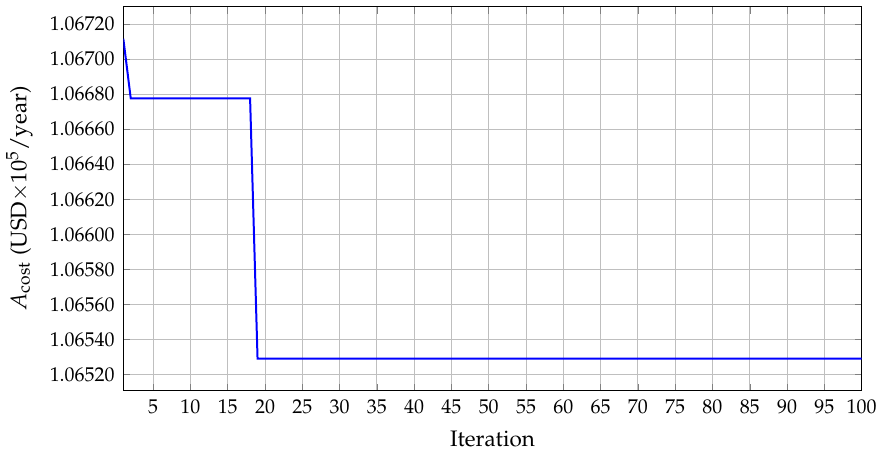
Figure 5. Convergence curve of the IEEE 33-node system with a radial configuration.